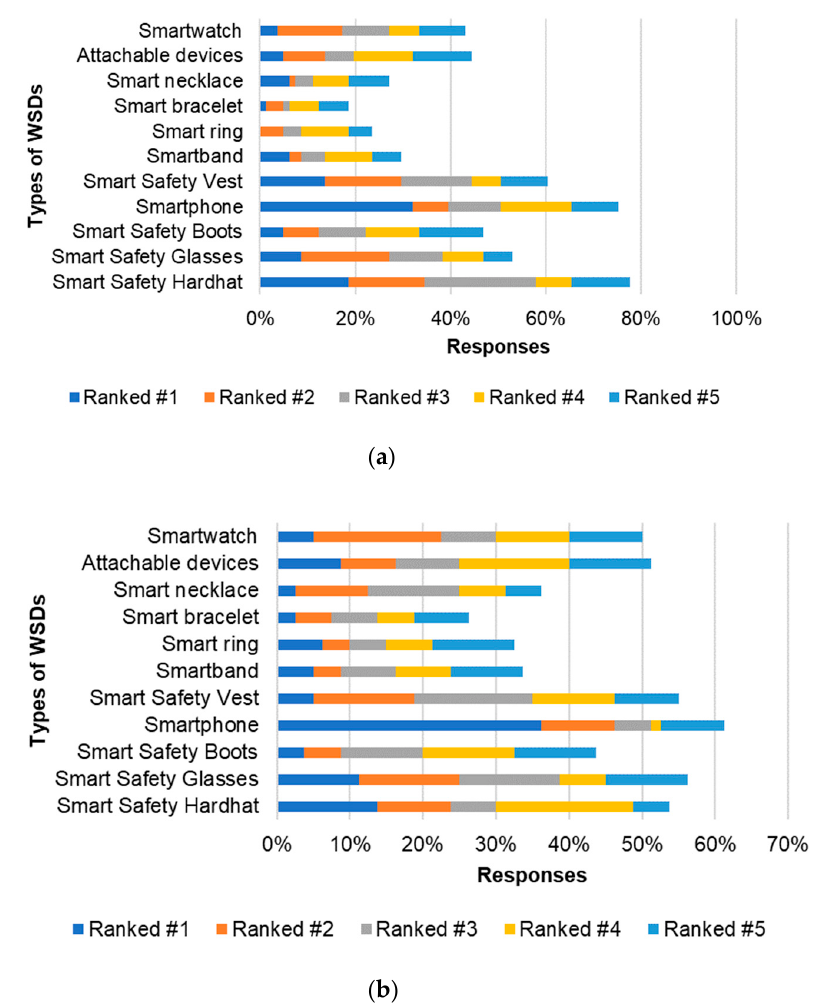
Figure 3. WSD Preference ( a ) FW ( n = 140); ( b ) MP ( n =